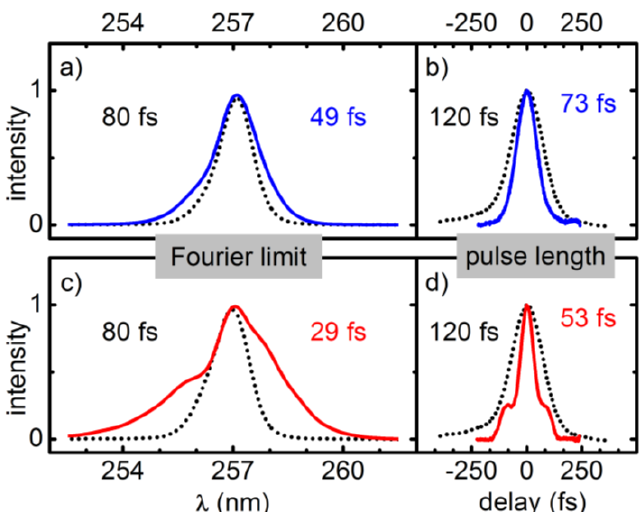
Figure 5. Pulse compression of the 120 fs third harmonic of the CPA by SPM broadening in a 1 mm CaF crystal and chirp compensation by a prism compressor. Dotted lines: input 2 pulses; solid lines: spectrally broadened pulses. Spectra ( a , c ) and autocorrelation measurements ( b , d ) of the complete beam profile (blue lines) and the central part of the beam profile (red